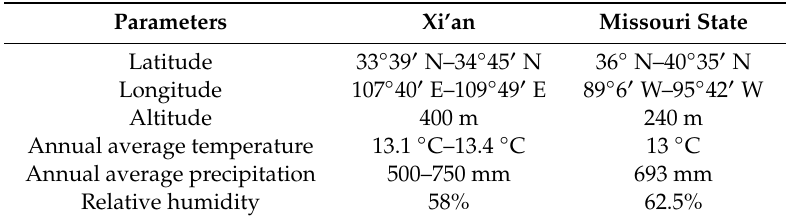
Table 2. Geographic features in Xi’an and Missouri.